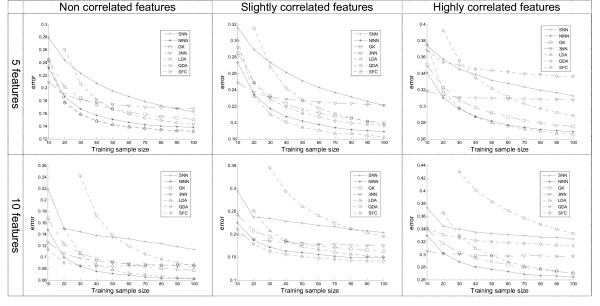
Comparison of various classifiers for linear model.